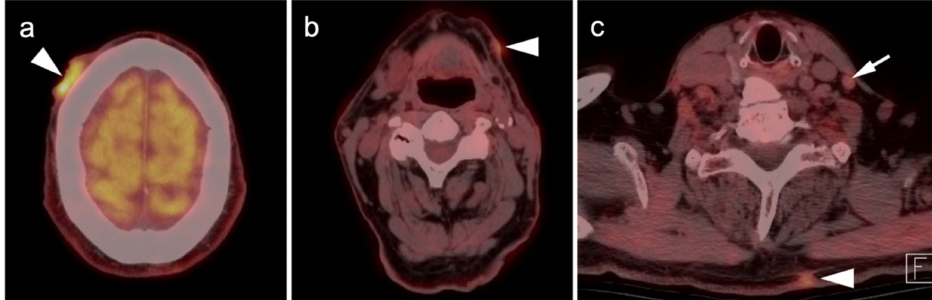
Figure 14. Multiple skin squamous cell carcinomas (SCCs) in a heart transplant patient. ( a ) Axial FDG PET-CT image of the upper head shows a large, ulcerated SCC in the right frontal scalp (white arrowhead). ( b ) Axial FDG PET-CT image of the upper neck shows that an additional SSC is present in the skin under the left jawline (white arrowhead). ( c ) Axial FDG PET-CT image of the lower neck shows a third lesion over the left medial posterior shoulder (white arrow). In addition, a prominent hypermetabolic left level 3/4B lymph node is noted (white